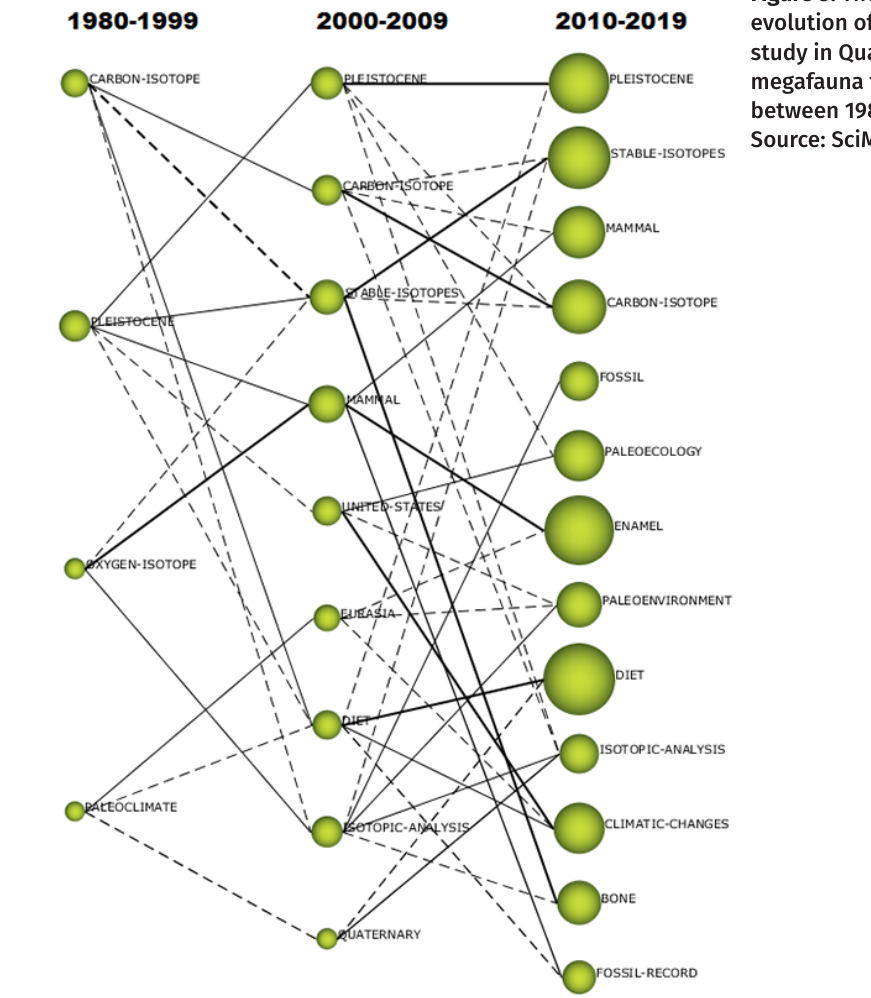
Figure 5. Thematic evolution of the isotopic study in Quaternary megafauna fossils between 1980 and 2019. Source: